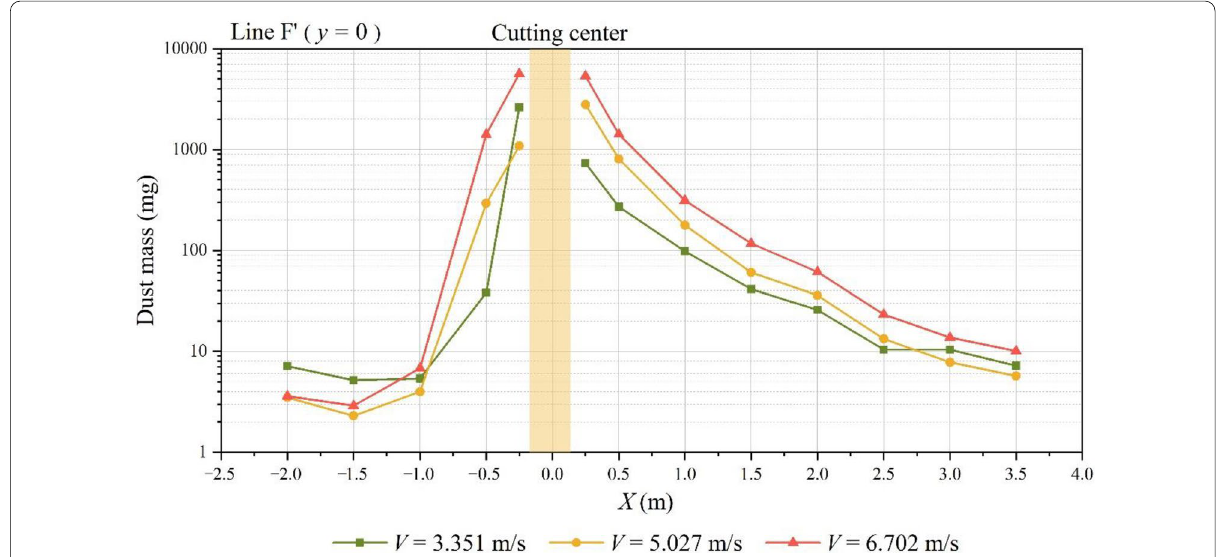
Fig. 5 The dust mass curves for dust particles collected from sampling points on Line F’ ( y